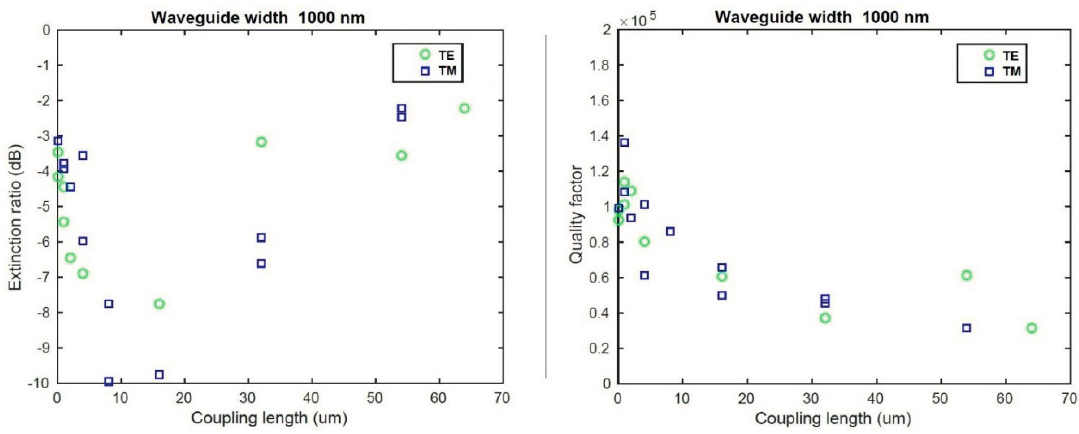
Figure 6. ( Left ) Extinction ratio analysis for the L2 sample; ( Right ) Quality factor analysis for the L2